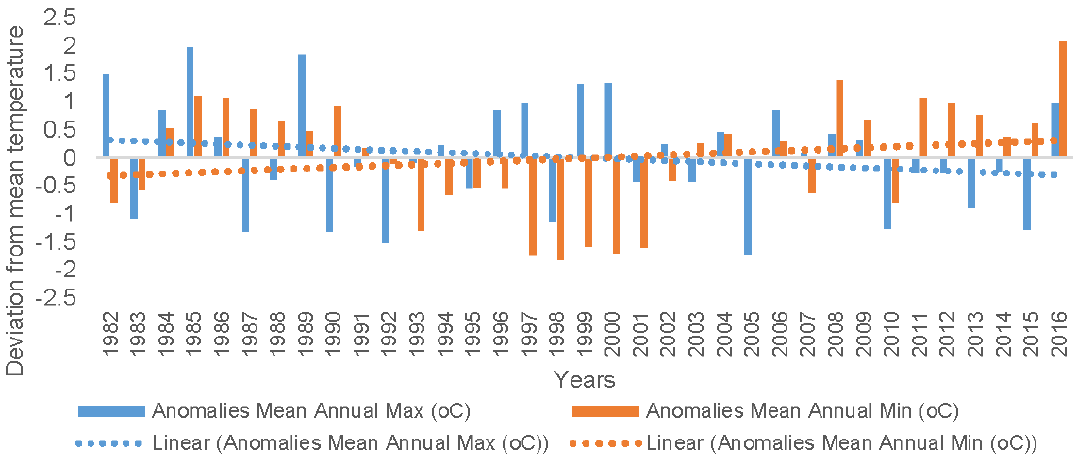
Figure 6. Annual maximum and minimum temperature anomalies for Dwangwa, Nkhotakota, Malawi in 1982 – 2016.